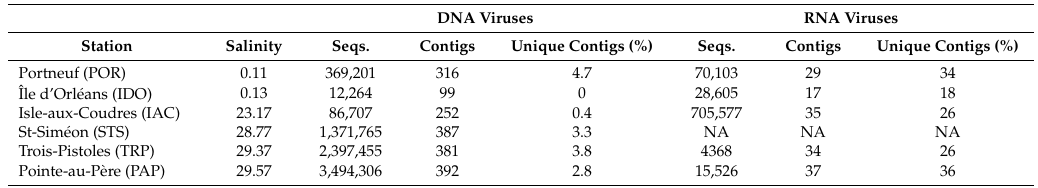
Table 2. Site salinity (as S P ) and number of viral sequences (Seqs.) and contigs (treated as Operational Taxonomic Units (OTUs)) from stations along a longitudinal transect of the St. Lawrence Estuary. The percentage of contigs unique to a given site is also given.